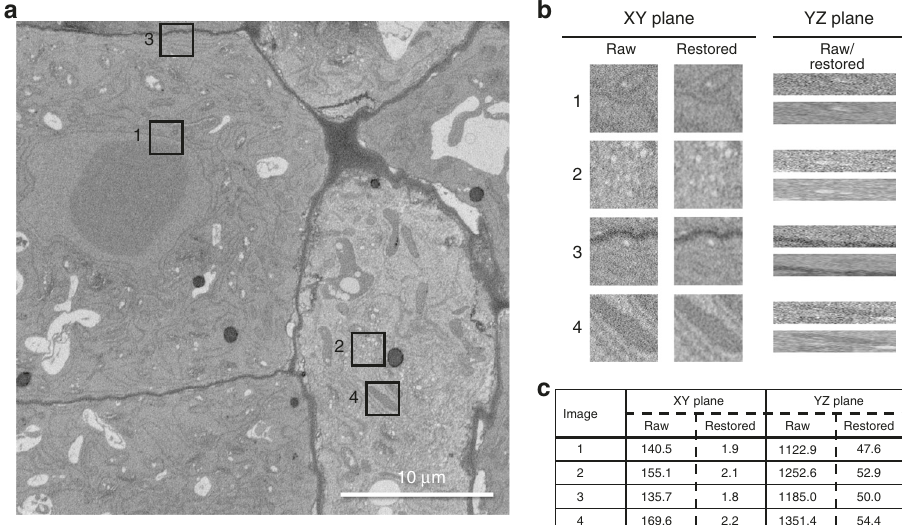
Fig. 3 An SBF-SEM section of an Arabidopsis thaliana root tip and four ROIs that show the denoising performance of DenoisEM. a The original image and four annotated ROIs and b a qualitative comparison of the original and denoised cross sections. For each ROI we show an XY and YZ section to illustrate that the image quality also improves along the Z direction, even though DenoisEM restores each XY slice independently. c For each ROI, we provide an estimation of the noise standard deviation σ n ref. 51 in the raw and denoised patch to illustrate the image quality quantitatively. Note that the noise level decreases by almost two orders of